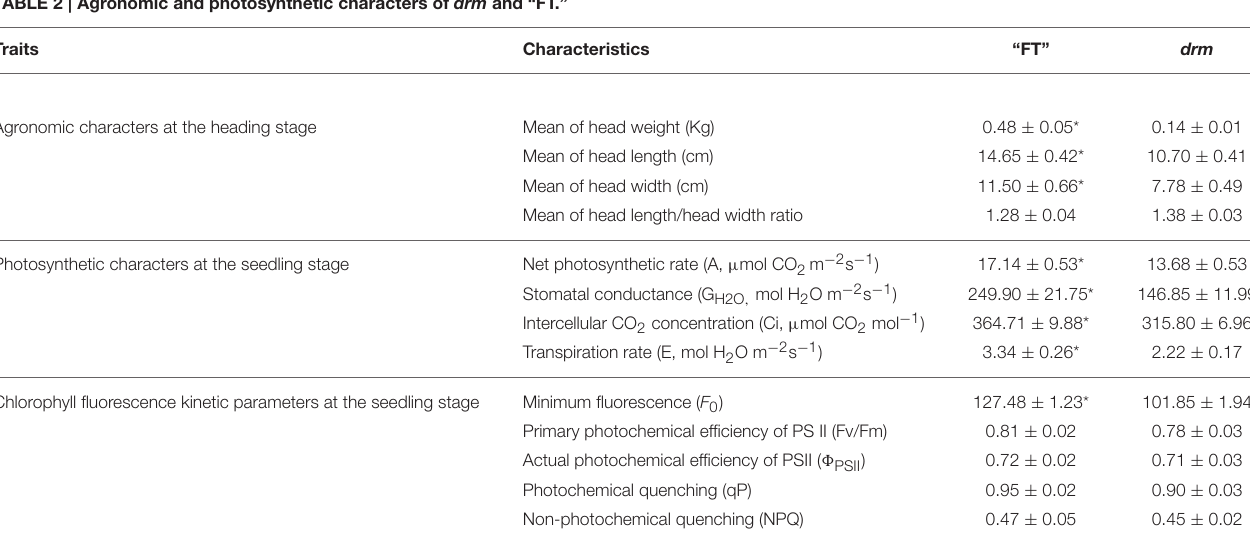
TABLE 2 | Agronomic and photosynthetic characters of drm and “FT.” Traits